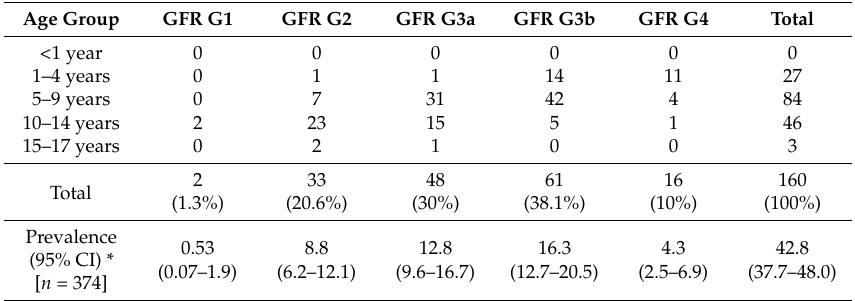
Table 4. Frequency and distribution of the Glomerular Filtration Rates (GFR) in the different age